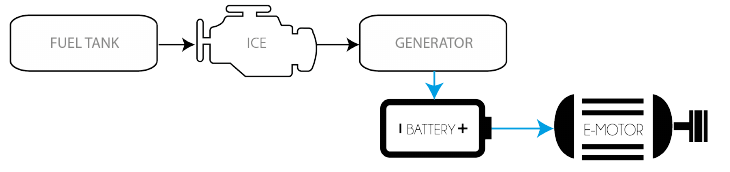
Figure 2. A diagram of the configuration of ICE-ER.